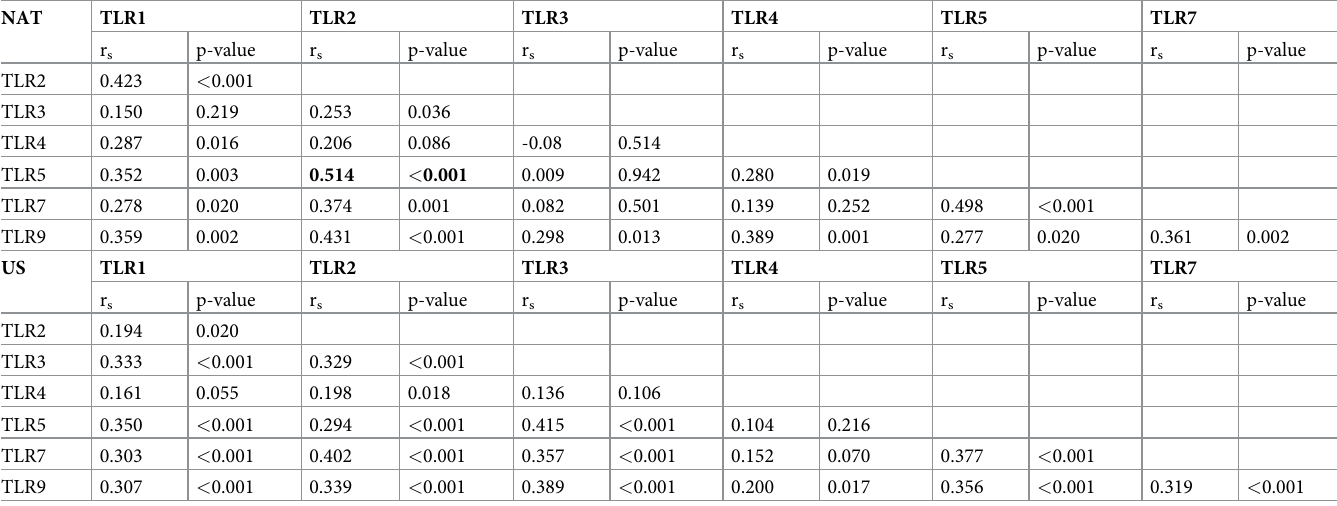
Table 3. Correlation of TLRs 1, 2, 3, 4, 5, 7, and 9 among patients treated with neoadjuvant therapy and upfront surgery.